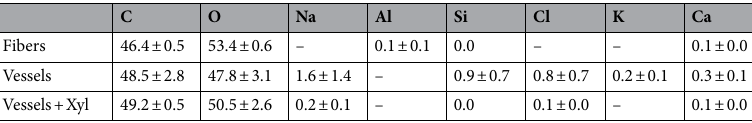
Table 5 compiles the XPS results for the surface relative con- centrations of elements and O/C ratio for the Whatman reference and all fiber and vessel samples untreated